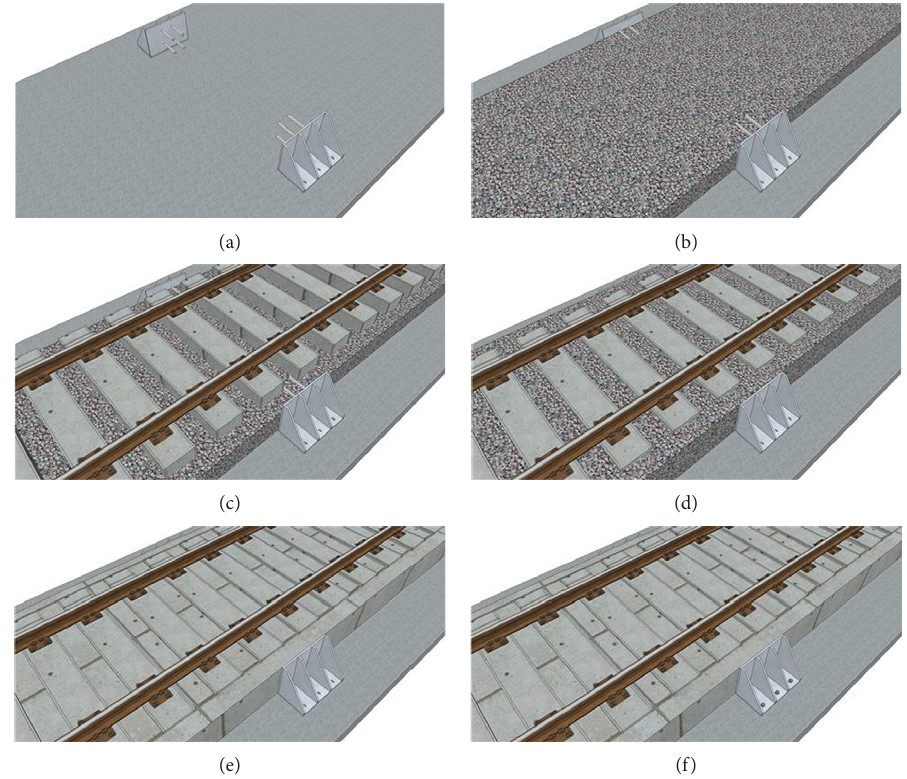
Figure 2: Concept of the anchor system for a quick-hardening track: (a) placing anchor brackets, (b) laying ballast, (c) installation of rails and sleepers, (d) laying additional ballast, (e) quick-hardening mortar injection and curing, and (f) installation of postinstalled